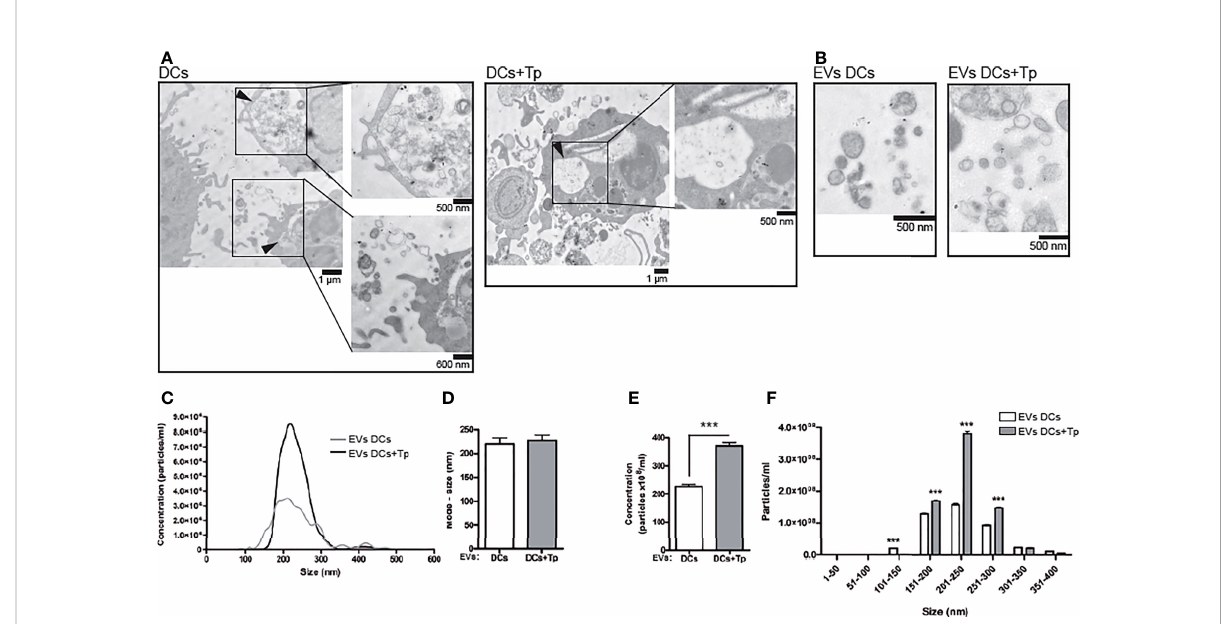
FIGURE 1 EVs from DCs+Tp presented higher diameters and abundance than EVs DCs. (A) Multivesicular compartments in DCs (upper panel) and DCs+Tp (lower panel) analyzed by TEM. Black arrows show ampli fi ed images. Bars, 500nm, 600 nm and 1µm. (B) EVs were isolated after sequential centrifugation from cultures of DCs at 1 ×10 6 cells/mL and 1:2 relation DC : Tp and processed for TEM. Bar, 500 nm. (C) Concentration distribution pro fi le of EVs by size from 0 to 600 nm by Nanoparticle Tracking Analysis. (D) Mode size of EVs derived from DCs or DCs+Tp. (E) Concentration of EVs based in size ranges. Statistical analysis was performed with Wilcoxon test, *** p <0.001. (F) EVs size distribution in 50 nm ranges. Statistical analysis was performed with two-way ANOVA and Bonferroni´s post-test, *** p